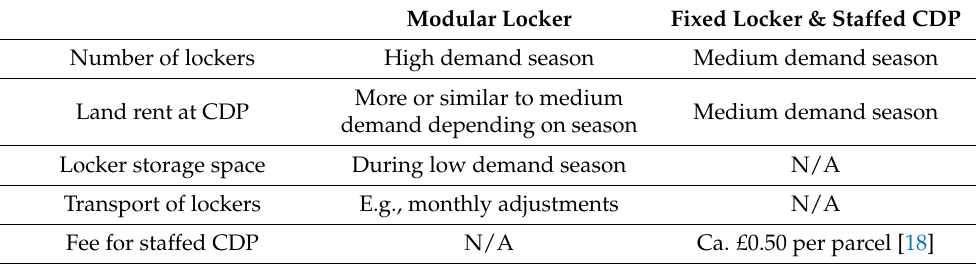
Table 1. Modular locker vs. fixed locker and staffed CDPs. Modular Locker Fixed Locker & Staffed